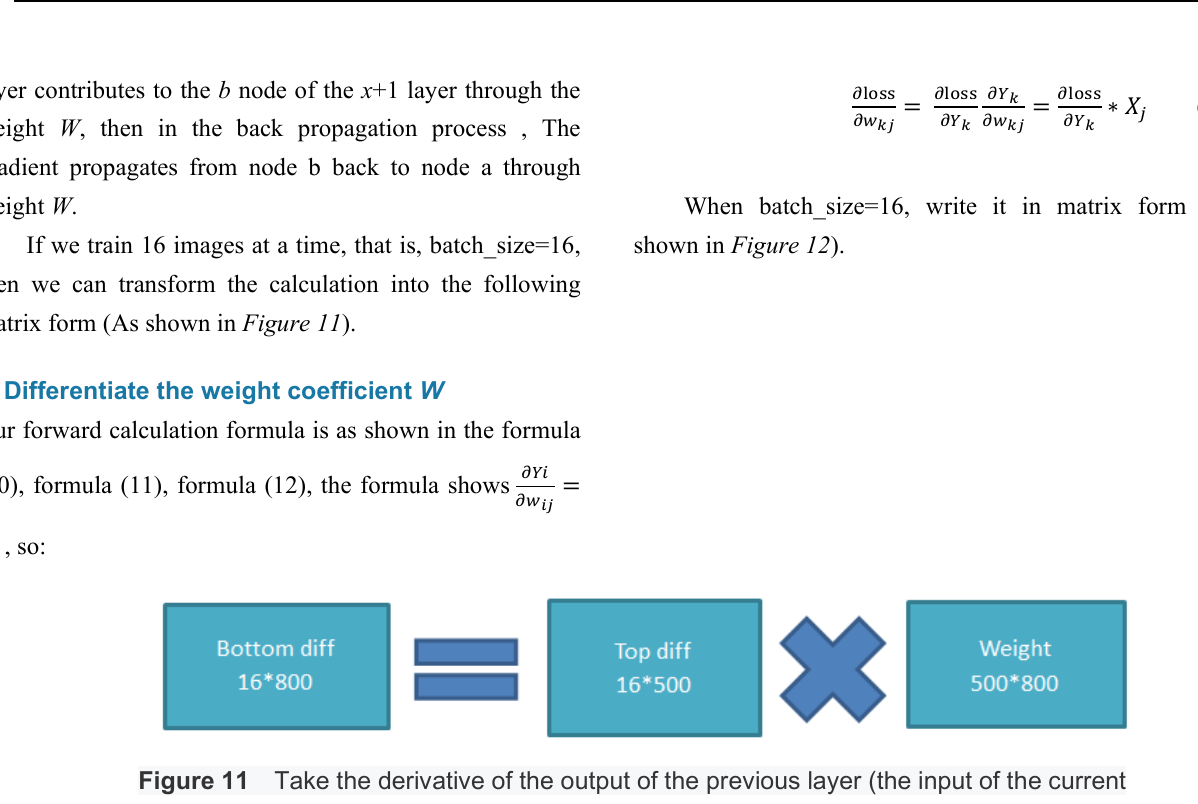
Take the derivative of the output of the previous layer (the input of the current layer)